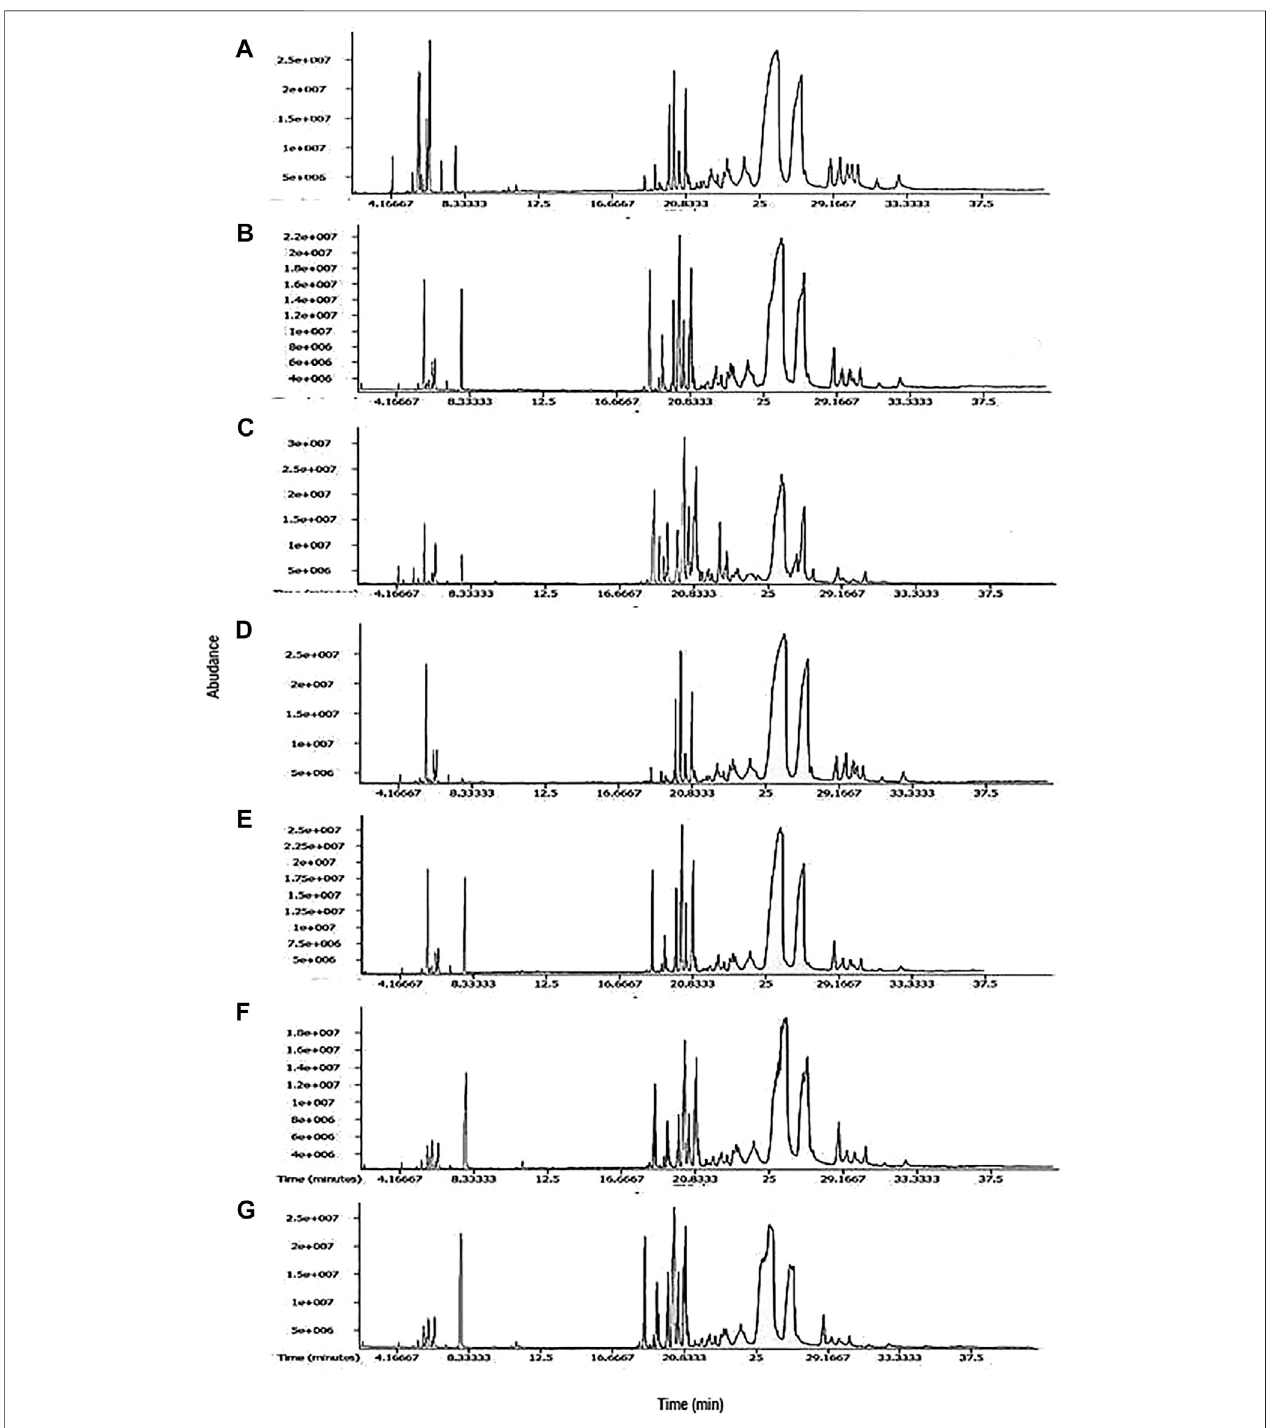
FIGURE 1 | Representative TIC chromatograms from GCMS of essential oil from cultivars (A) Alleppey Supreme, (B) Duggirala Red, (C) Prathibha, (D) Salem, (E) Suguna of Curcuma longa L. and cvs. (F) Kasturi Araku, (G) Kasturi Avidi of C. aromatica Salisb.